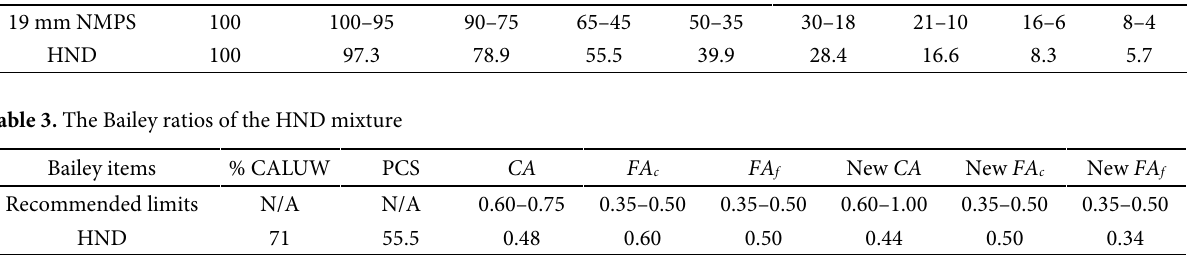
Table 1. The effects of Bailey principles on VMA Parameters To increase VMA To decrease VMA Increase (for coarse graded mixture) Decrease (for coarse graded mixture) CALUW Decrease (for fine graded mixture) Increase (for fine graded mixture) CA / New CA Increase ratio Decrease ratio FA c / New FA c Decrease ratio Increase ratio FA f / New FA f Decrease ratio Increase ratio Table 2. The job mix gradation limits for 19 mm NMPS and the sieve size distributions of the HND mixture Percent of passing by weight, % Sieve